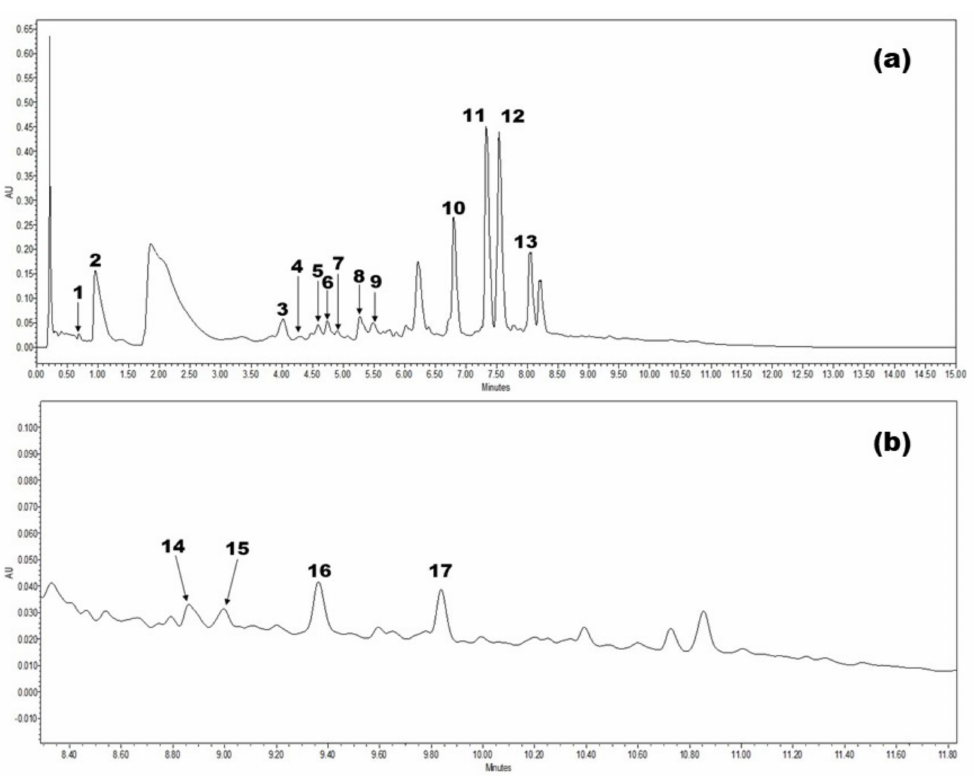
Figure A2. Chromatogram of leaves extracts obtained from habanero pepper plants grown in black soil. ( a ) Complete chromatogram. ( b ) Zoom of chromatogram of sample with zoom from 8.40 to 11.80 minutes. The numbers correspond to: (1) gallic acid, (2) protocatechuic acid, (3) catechin, (4) chlorogenic acid, (5) vanillin, (6) ρ -coumaric acid, (7) coumaric acid, (8) cinnamic acid, (9) rutin, (10) myricetin, (11) hesperidin + diosmin, (12) neohesperidin, (13) quercetin + luteolin, (14) naringenin, (15) apigenin, (16) kaempferol and (17) diosmetin.